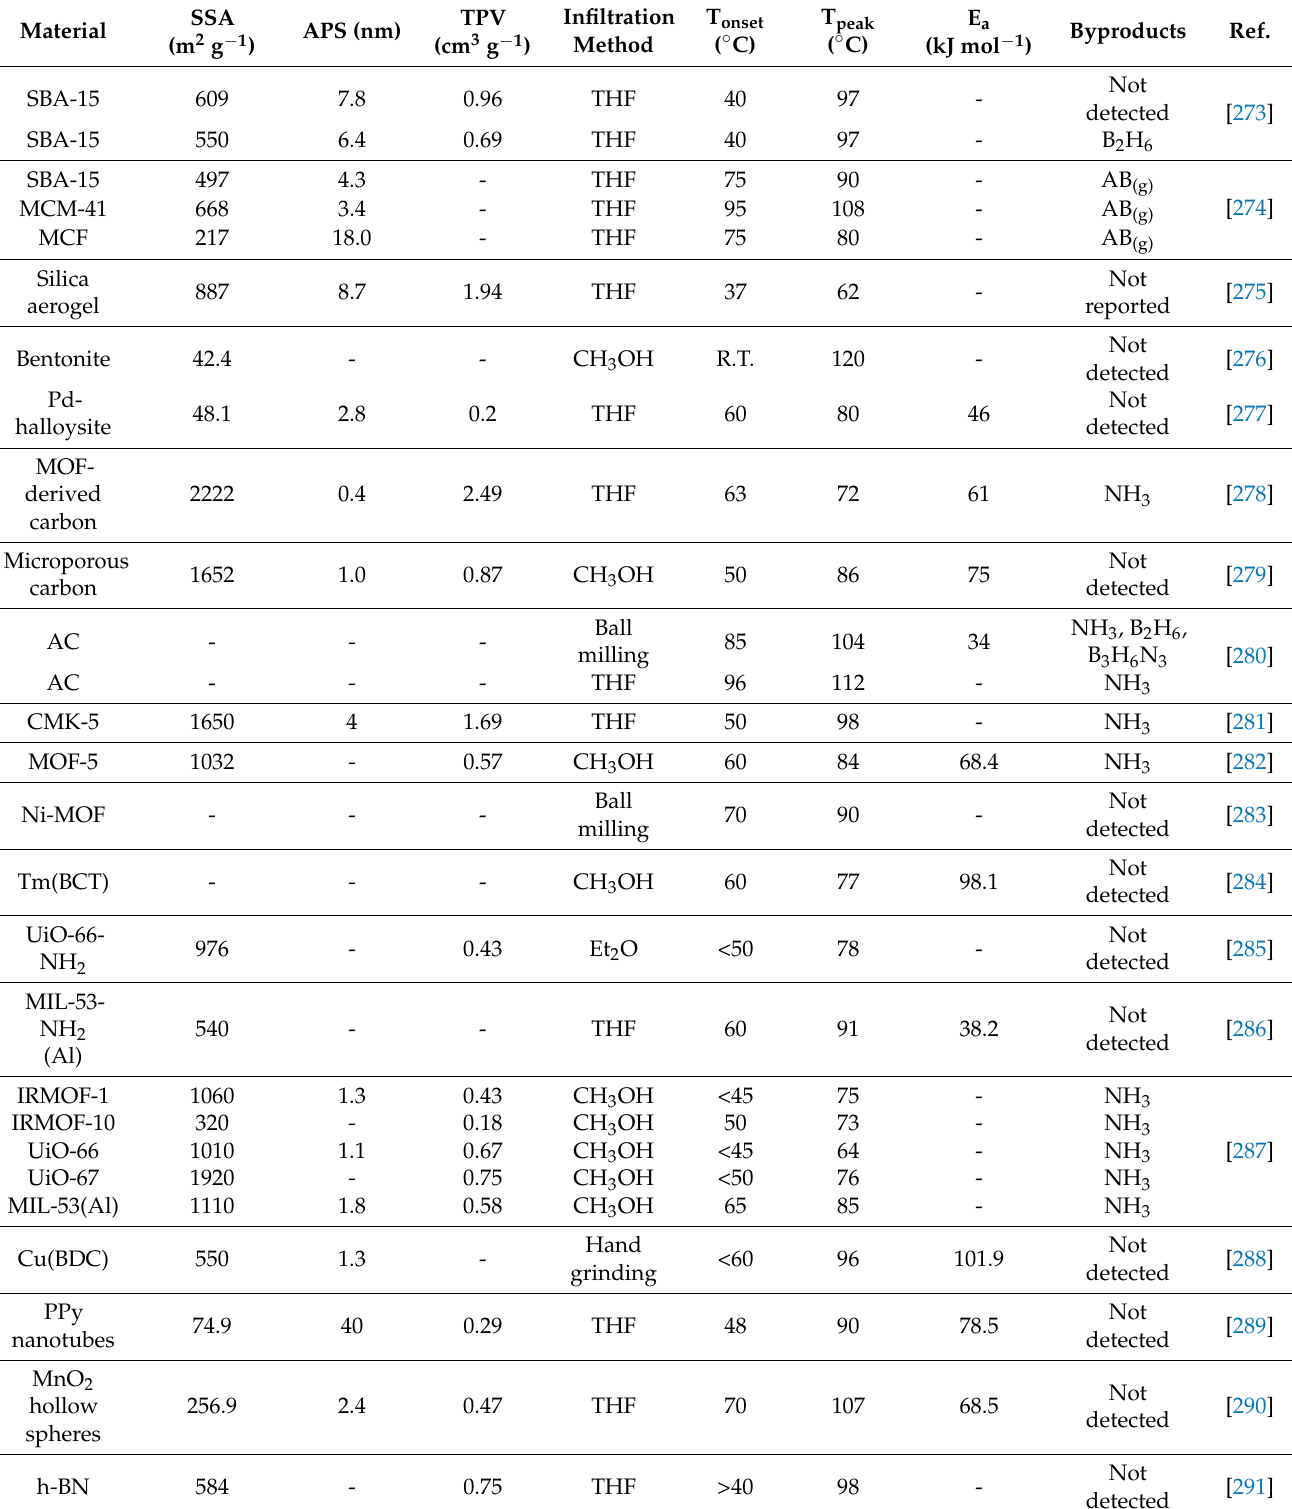
Table 1. List of materials investigated as scaffolds for AB confinement. The material and its textural properties (specific surface area, SSA; average pore size, APS; total pore volume, TPV) are given, when available. Other details about the infiltration method; the onset dehydrogenation temperature, T onset ; the peak at which H 2 is released, T peak ; the activation energy, E a ; and the byproducts detected from the sample are given, when